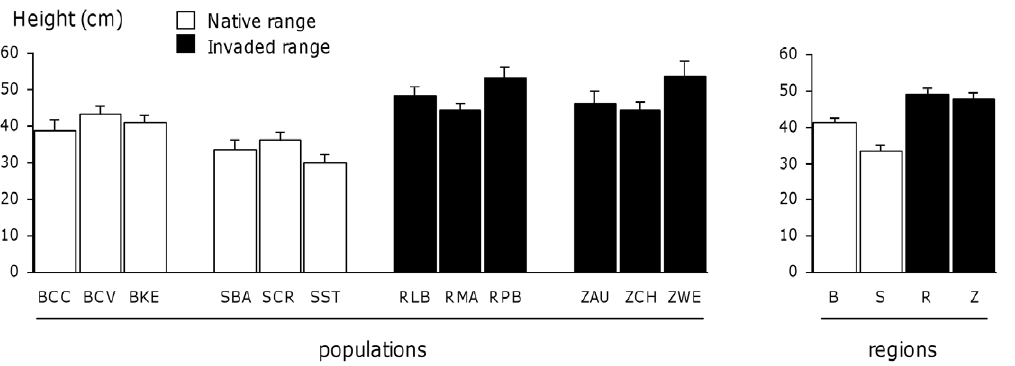
Figure 1. Height of one-year-old U.europaeus plants grown in a glasshouse. Population and regional means are given with 1 SE. N=265.